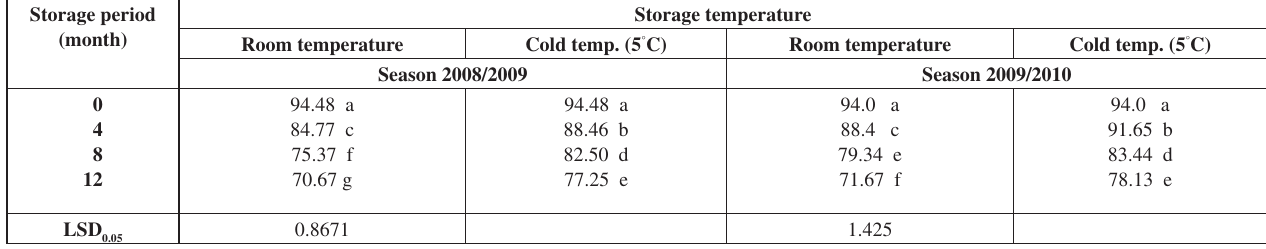
Table 7: Effect of the interaction between storage temperature and storage period on germination percentage of onion seeds during seasons of 2008/2009 and